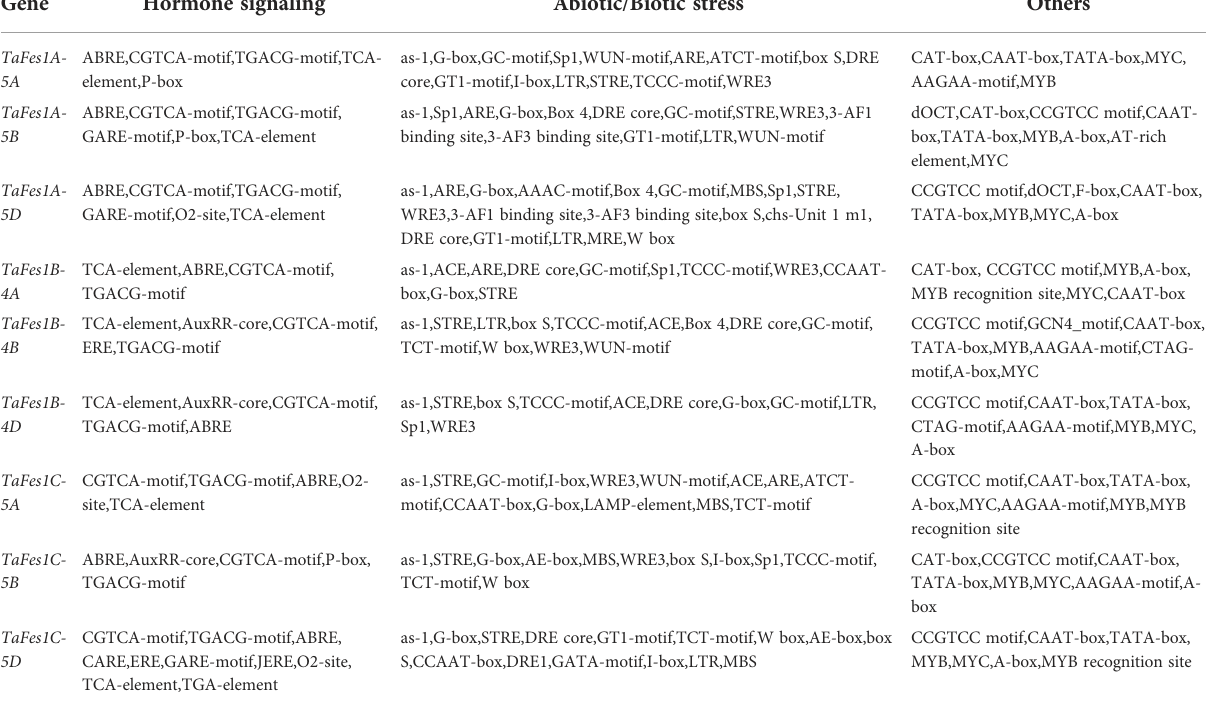
TABLE 2 Distribution of cis-elements in promoters of TaFes1s